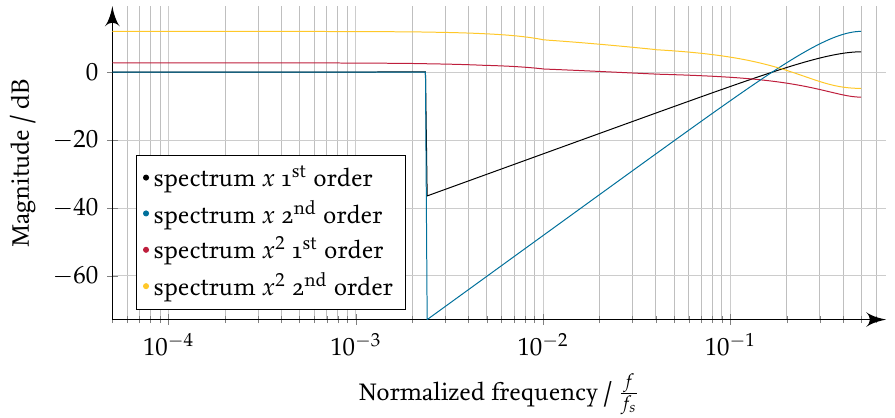
Figure 20. Output spectra of a first and a second order ∆Σ -Ms and of the signals squared in time domain.